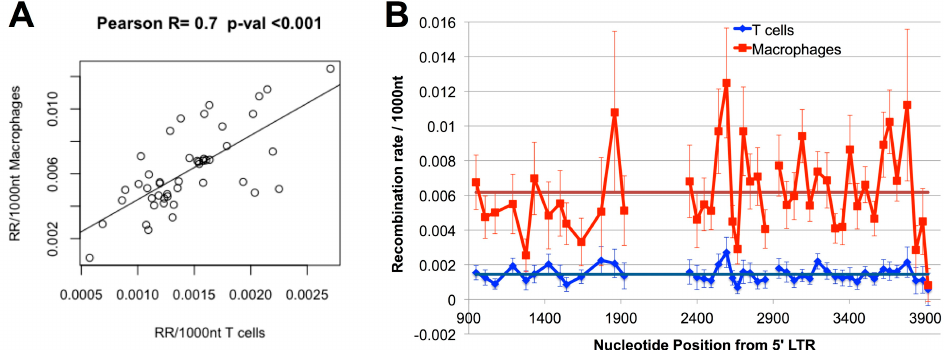
Figure 3. Recombination rates in T-cells and macrophages by interval. ( A ) Recombination rate in each interval in macrophages is correlated with the recombination rate in the same interval in T-cells ( r = 0.7, p < 0.001) Note the different scales used on the x and y axes. ( B ) Recombination rates in macrophages and T-cells in each interval. 95% confidence intervals are shown (after Bonferroni correction for multiple comparisons). Dark lines indicate the average recombination rate (RR) across all intervals for T-cells (blue) and macrophages